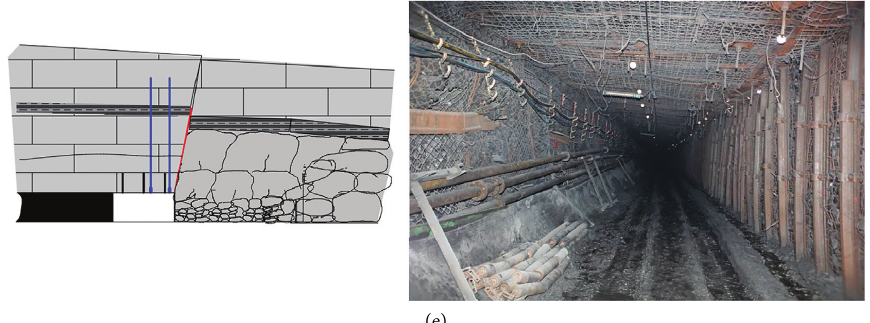
Figure 11: The nonpillar entire mining process. (a) Applying constant resistance and large deformation anchor cable. (b) Roof presplitting and slitting. (c) Roof shallow hole blasting. (d) Hydraulic supports in the roadway and after the working face is mined, the roof of the goaf gradually collapses. (e) The roadway is stable, and the hydraulic supports are